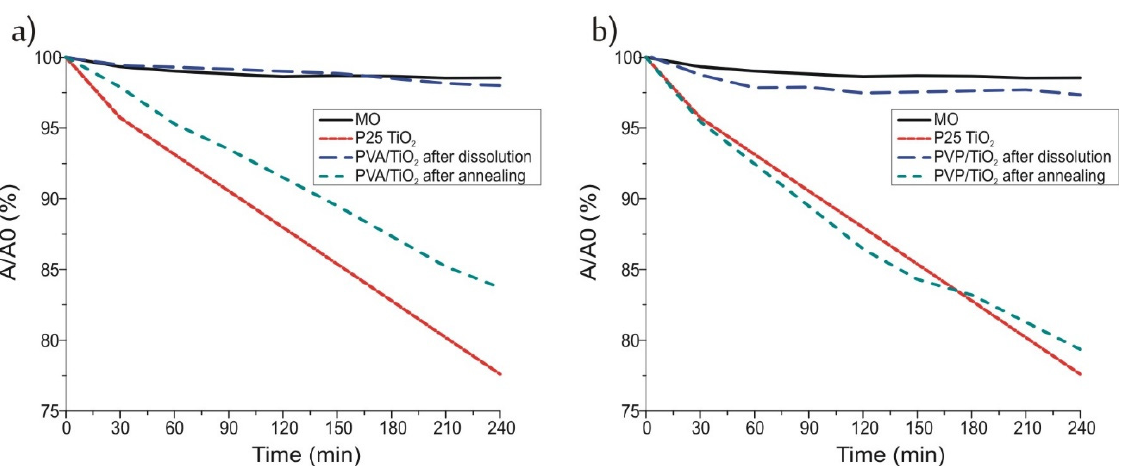
Figure 7. Photocatalysis of the TiO 2 nanotubes prepared from ( a ) PVA/TiO 2 , ( b ) PVP/TiO 2 composite.